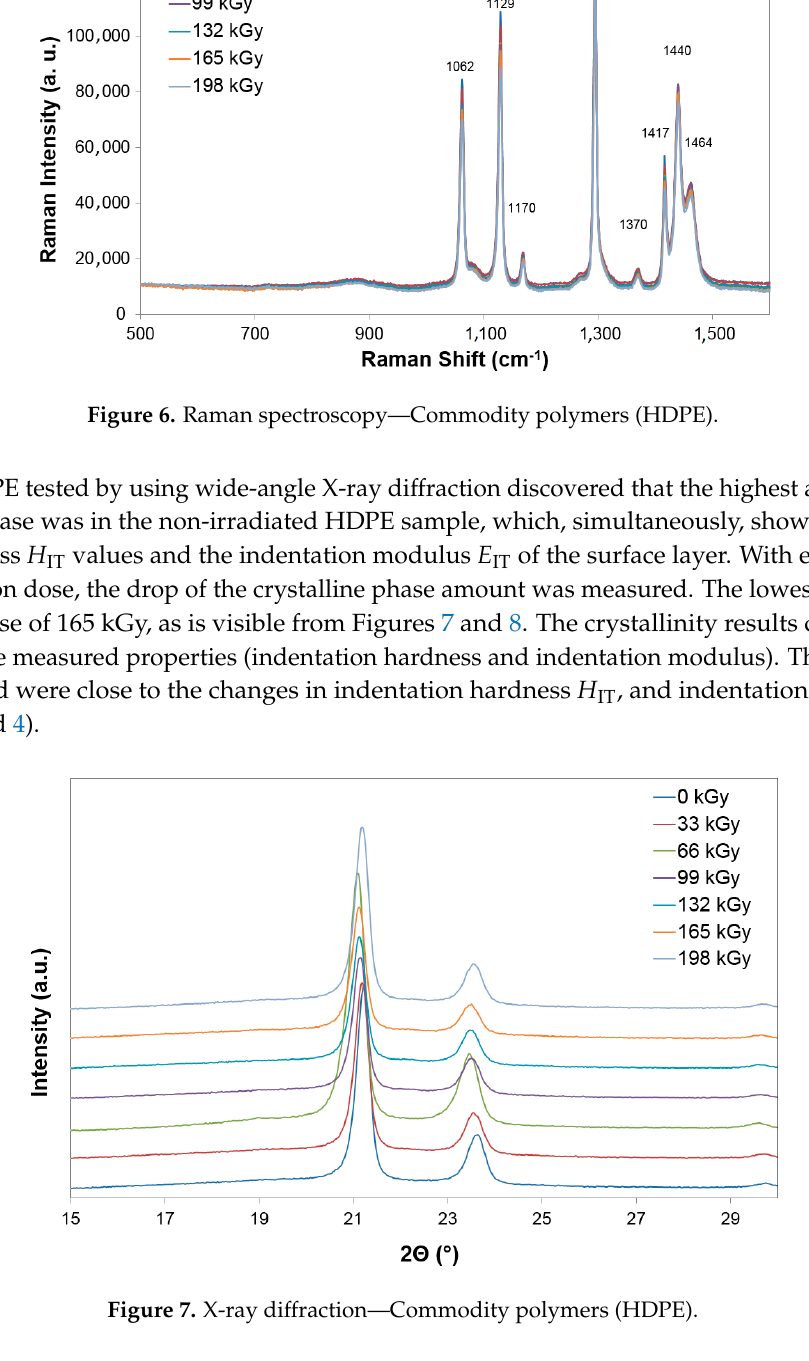
Figure 8. X-ray diffraction—Crystallinity—Commodity polymers (HDPE). For polyethylene, the increasing radiation dose leads to increases as the crystalline phase decreases, which is due to the fact that parts that were crystalline in the non-irradiated sample transform into its amorphous phase. At the radiation dose of 198 kGy, irradiation is affected by chain irradiation in the amorphous phase—Which causes the loosening of the chains able to associate with other strings, thereby increasing the crystalline phase. 3.1.3. Thermo-Mechanical Properties Temperature stability is assessed by using thermo-mechanical analysis, which is a precise evaluation technique of temperature resistance against hot probes, with a loading of 160 mN. The sensitive probe records data in a set range of temperatures; measurement times make it possible to observe graphical depictions. The second form of temperature stability evaluation is visual observation within the temperature chamber. It is not so precise, nor as sensitive, a technique as TMA but, from the macroscopic point of view, deformation under temperature is clear at first sight.